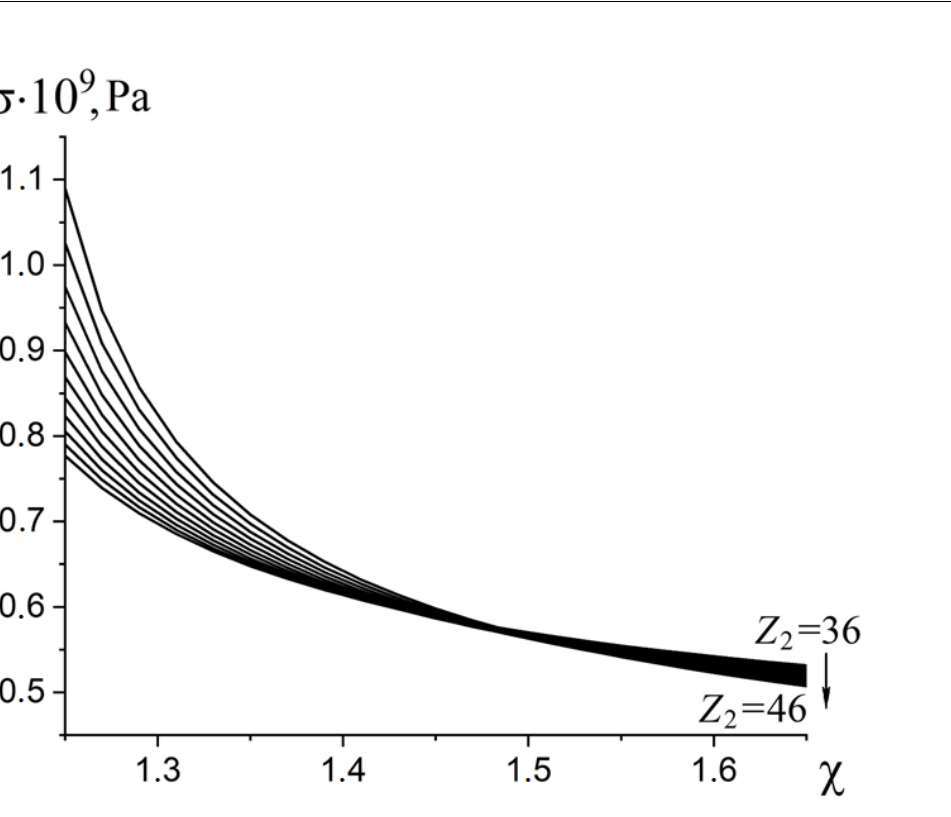
Figure 7. Dependence of the maximum contact stress on the displacement coefficient χ at different values of the rolling elements number Z 2 .